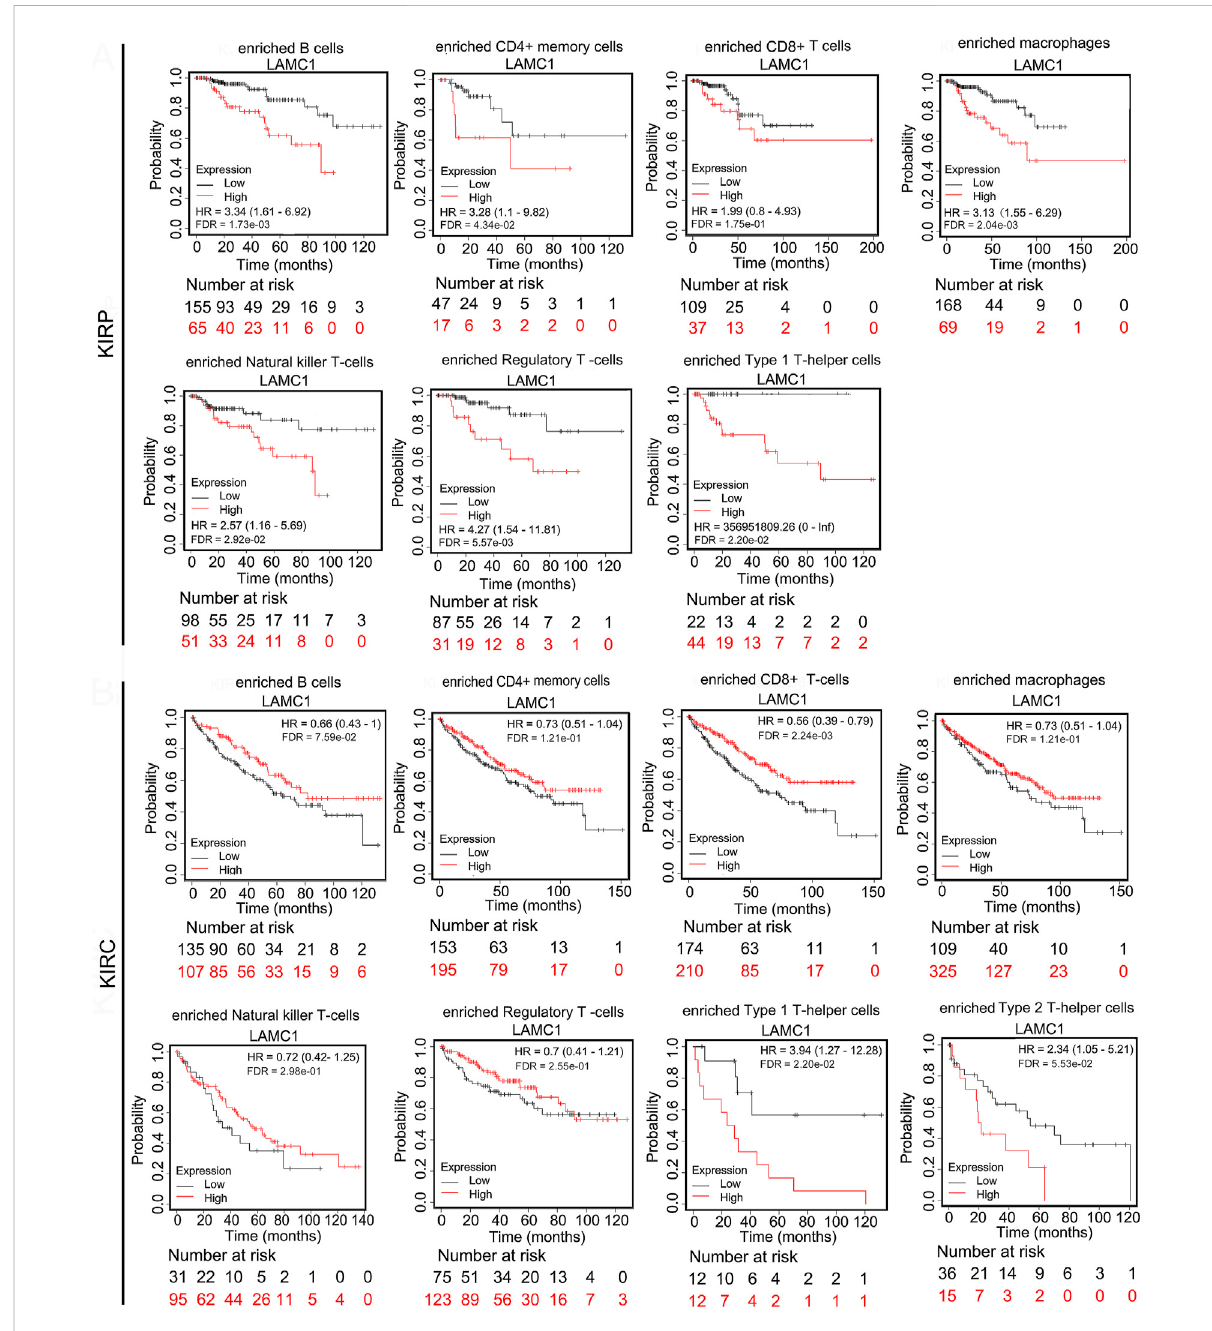
FIGURE 6 Kaplan – Meier survivalcurvesfor RCCpatients withdifferential LAMC1 expression wereconstructed basedonimmunecells enrichmentinRCC